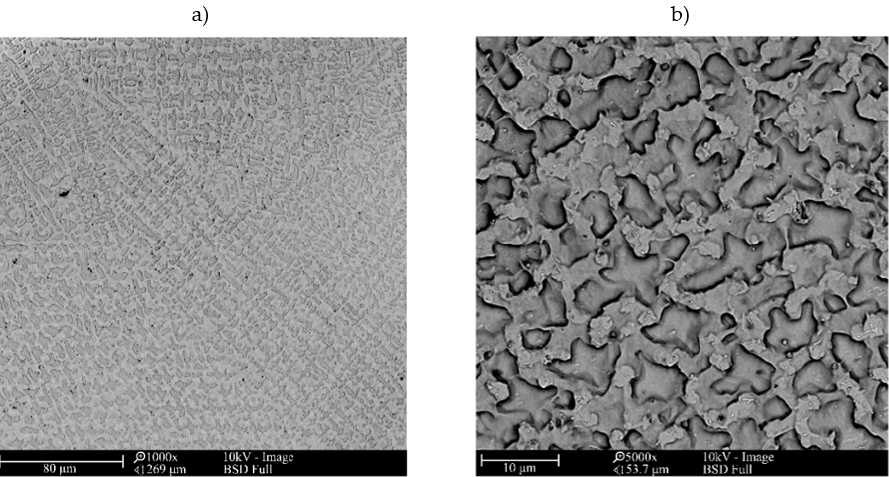
Figure 5. The SEM microstructure of the central bead area of the laser cladded Inconel 625 coating I-01, magnification ( a ) 1000 × , ( b ) 5000 × (coating designation according to Table 3).